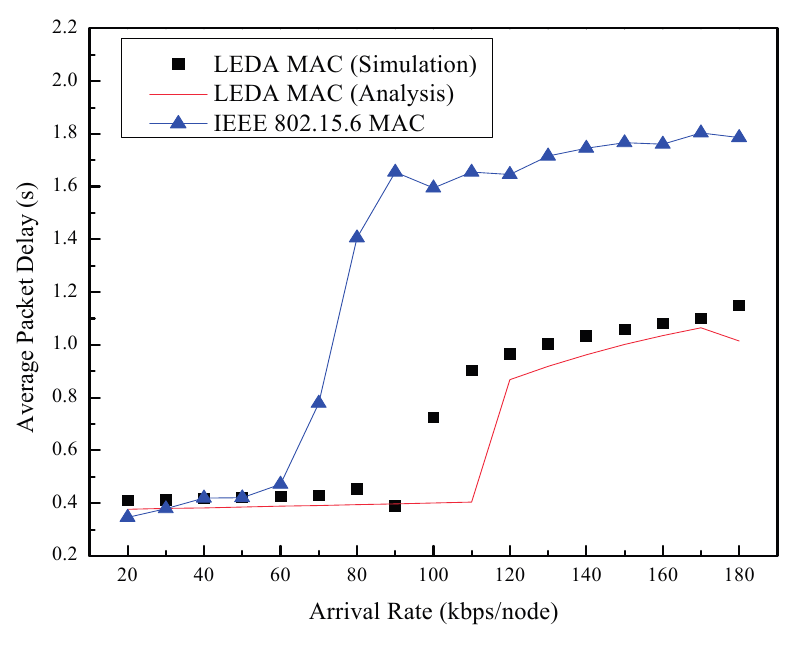
Figure 13. Network throughput vs. arrival rate.